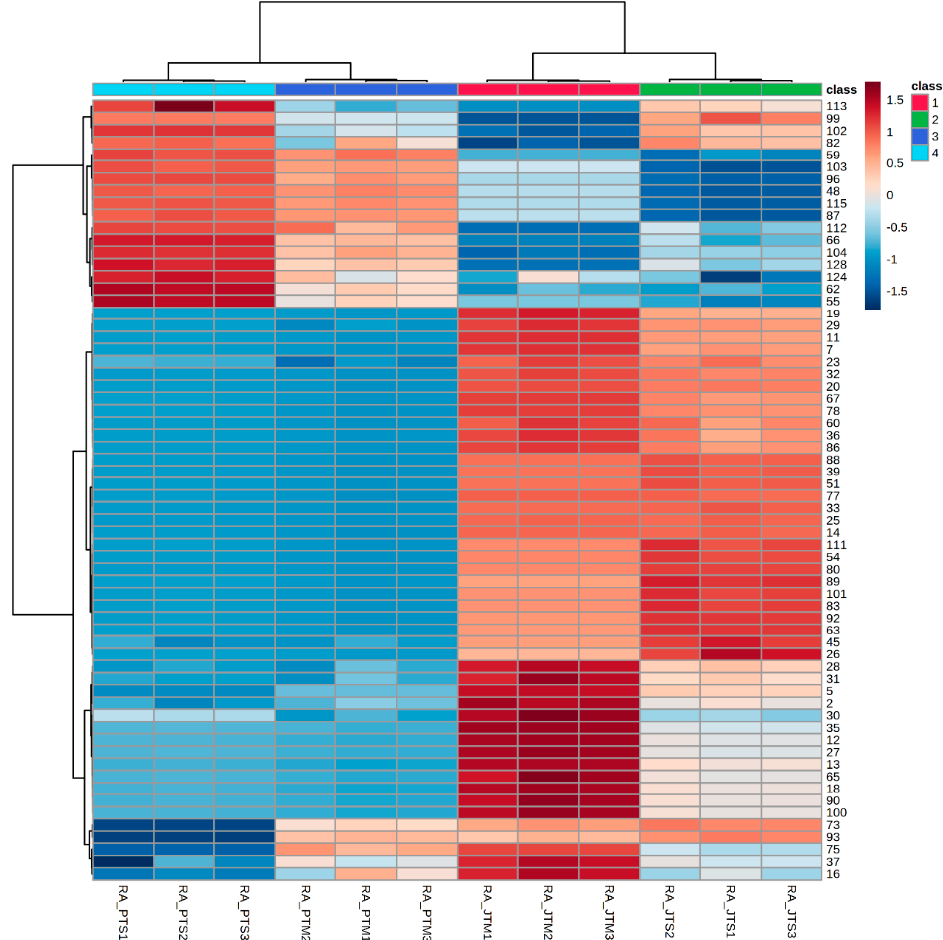
Figure 5. Hierarchical cluster analysis (HCA) analysis of the volatomic data obtained in this work, as described in Materials and Methods section.